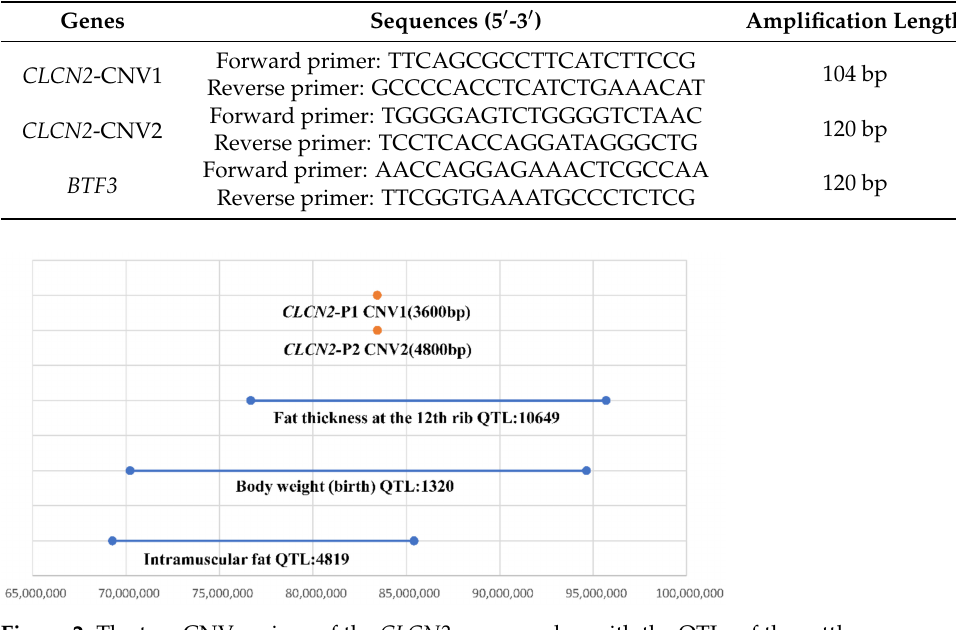
Figure 2. The two CNV regions of the CLCN2 gene overlap with the QTLs of the